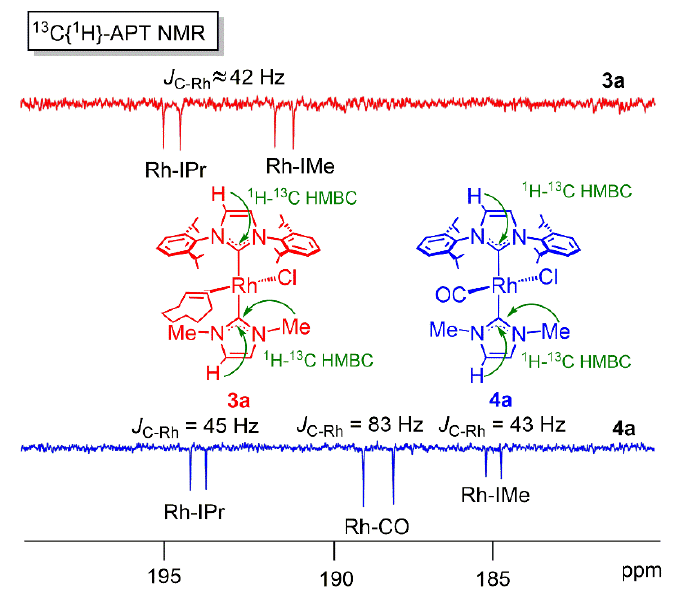
Figure 2. Downfield area of the 13 C{ 1 H}-APT NMR spectra of 3a and 4a . Wingtip functionalized NHCs ligands can also participate in the formation of mixed bis-NHC rhodium(I) complexes. In this context, coumarin-functionalized-NHC metal complexes display interesting catalytic and luminescence properties [62–66]. In particular, we have prepared coumarin-NHC derivatives of type RhCl(NHC-Cou)( η 2 , η 2 -cod) ( 5 ) in which, in contrast to the behavior observed for related IPr- or IMes-cod compounds, the diolefin ligand can be replaced in the presence of an excess of carbene to yield bis-NHC complexes [53]. Thus, a stepwise reaction using different carbene precursors enabled the synthesis of mixed-NHC species (Scheme 3). In this way, an imidazole-benzimidazole mixed-NHC complex RhCl( κ C , η 2 -BzICou tol )( κ C , η 2 -ICou Bz ) {BzICou tol = 1-(4-methylbenzyl)-3-(7,8-dimethyl-2 H -chromen-2-one-4-yl)benzimidazolin-2-carbene, ICou Bz = 1-(benzyl)-3-(7,8-dimethyl-2 H -chromen-2-one-4-yl)imidazolin-2-carbene} ( 6 ) was obtained by refluxing a THF solution of the precursor RhCl(BzICou tol )( η 2 , η 2 -cod)] ( 5a ) and the azolium salt [HICou Bz ]Cl in the pres- ( 7 ) was formed starting from RhCl(BzICou bu )( η 2 , η 2 -cod) ( 5b ) and free IPr. Although the solid state structure of 6 could not be determined by X-ray diffraction methods, a trigo- nal bipyramidal structure with a trans disposition of the NHC ligands is assumed in an analogy to the related coumarin-functionalized bis-NHC complexes RhCl(BzICou R ) 2 and RhCl(ICou R ) 2 described previously [53]. Interestingly, the X-ray single-crystal analysis of the mixed bis-NHC compound 7 revealed a cis disposition for the IPr and coumarin-BzI carbenes, an uncommon feature in square planar rhodium(I) complexes when a trans configuration is feasible [67,68] (Figure 3).